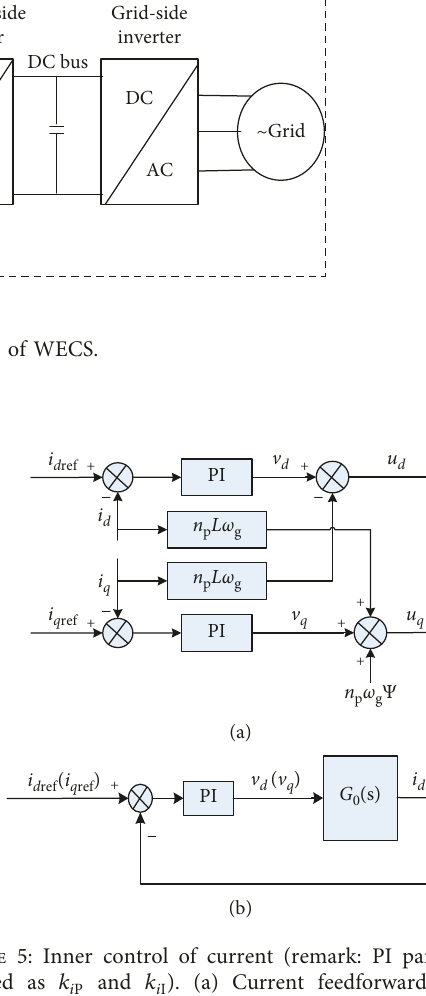
Figure 4: 2-MW baseline wind turbine power coefficient.